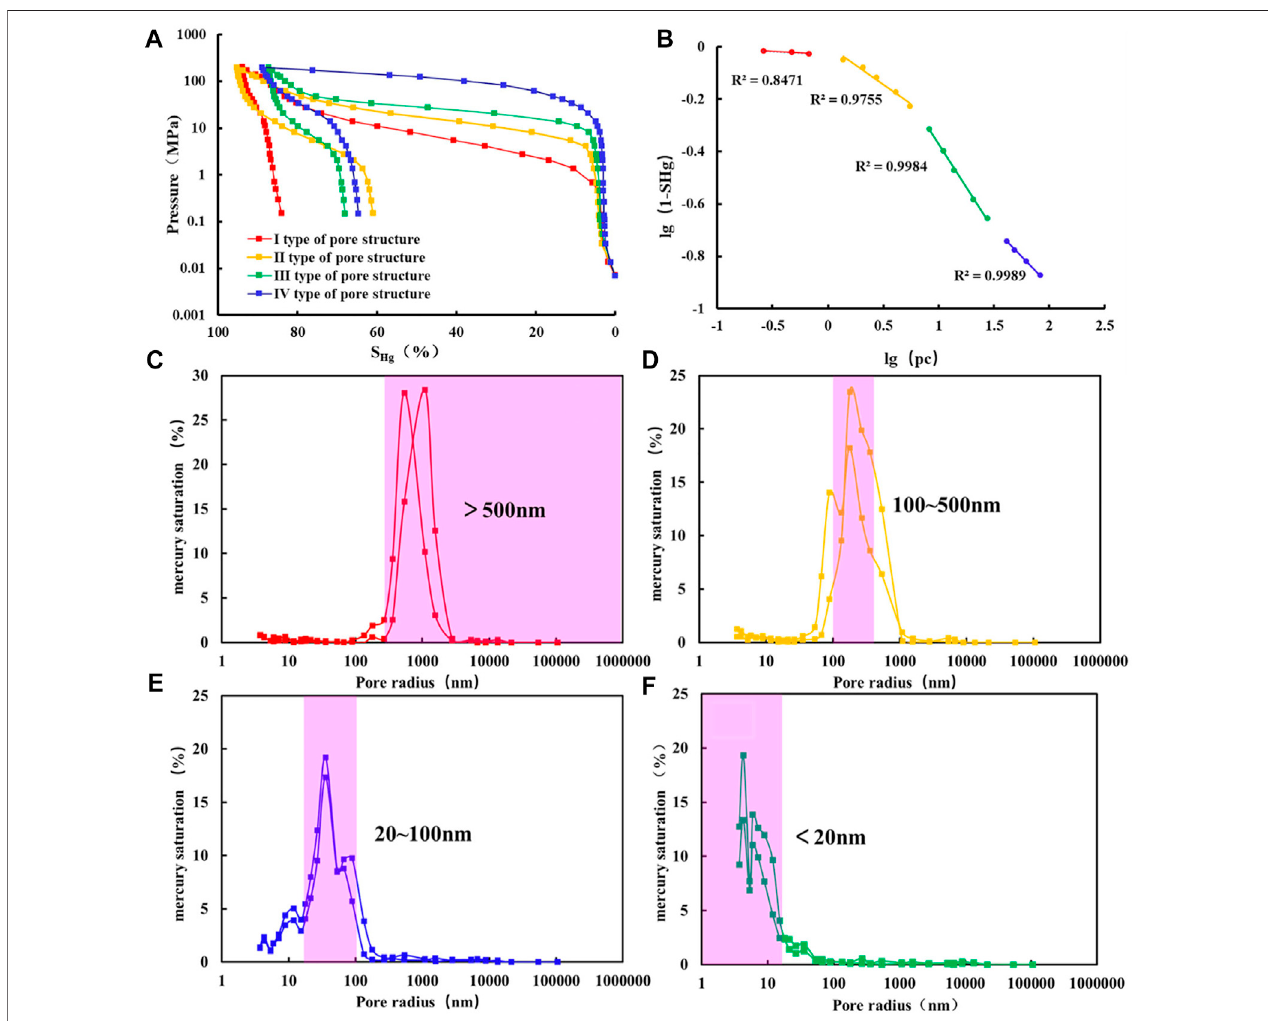
FIGURE 9 | (A) Typical MICP features; (B) Typical MICP fractal features; and (C – F) MICP pore size distribution characteristics.